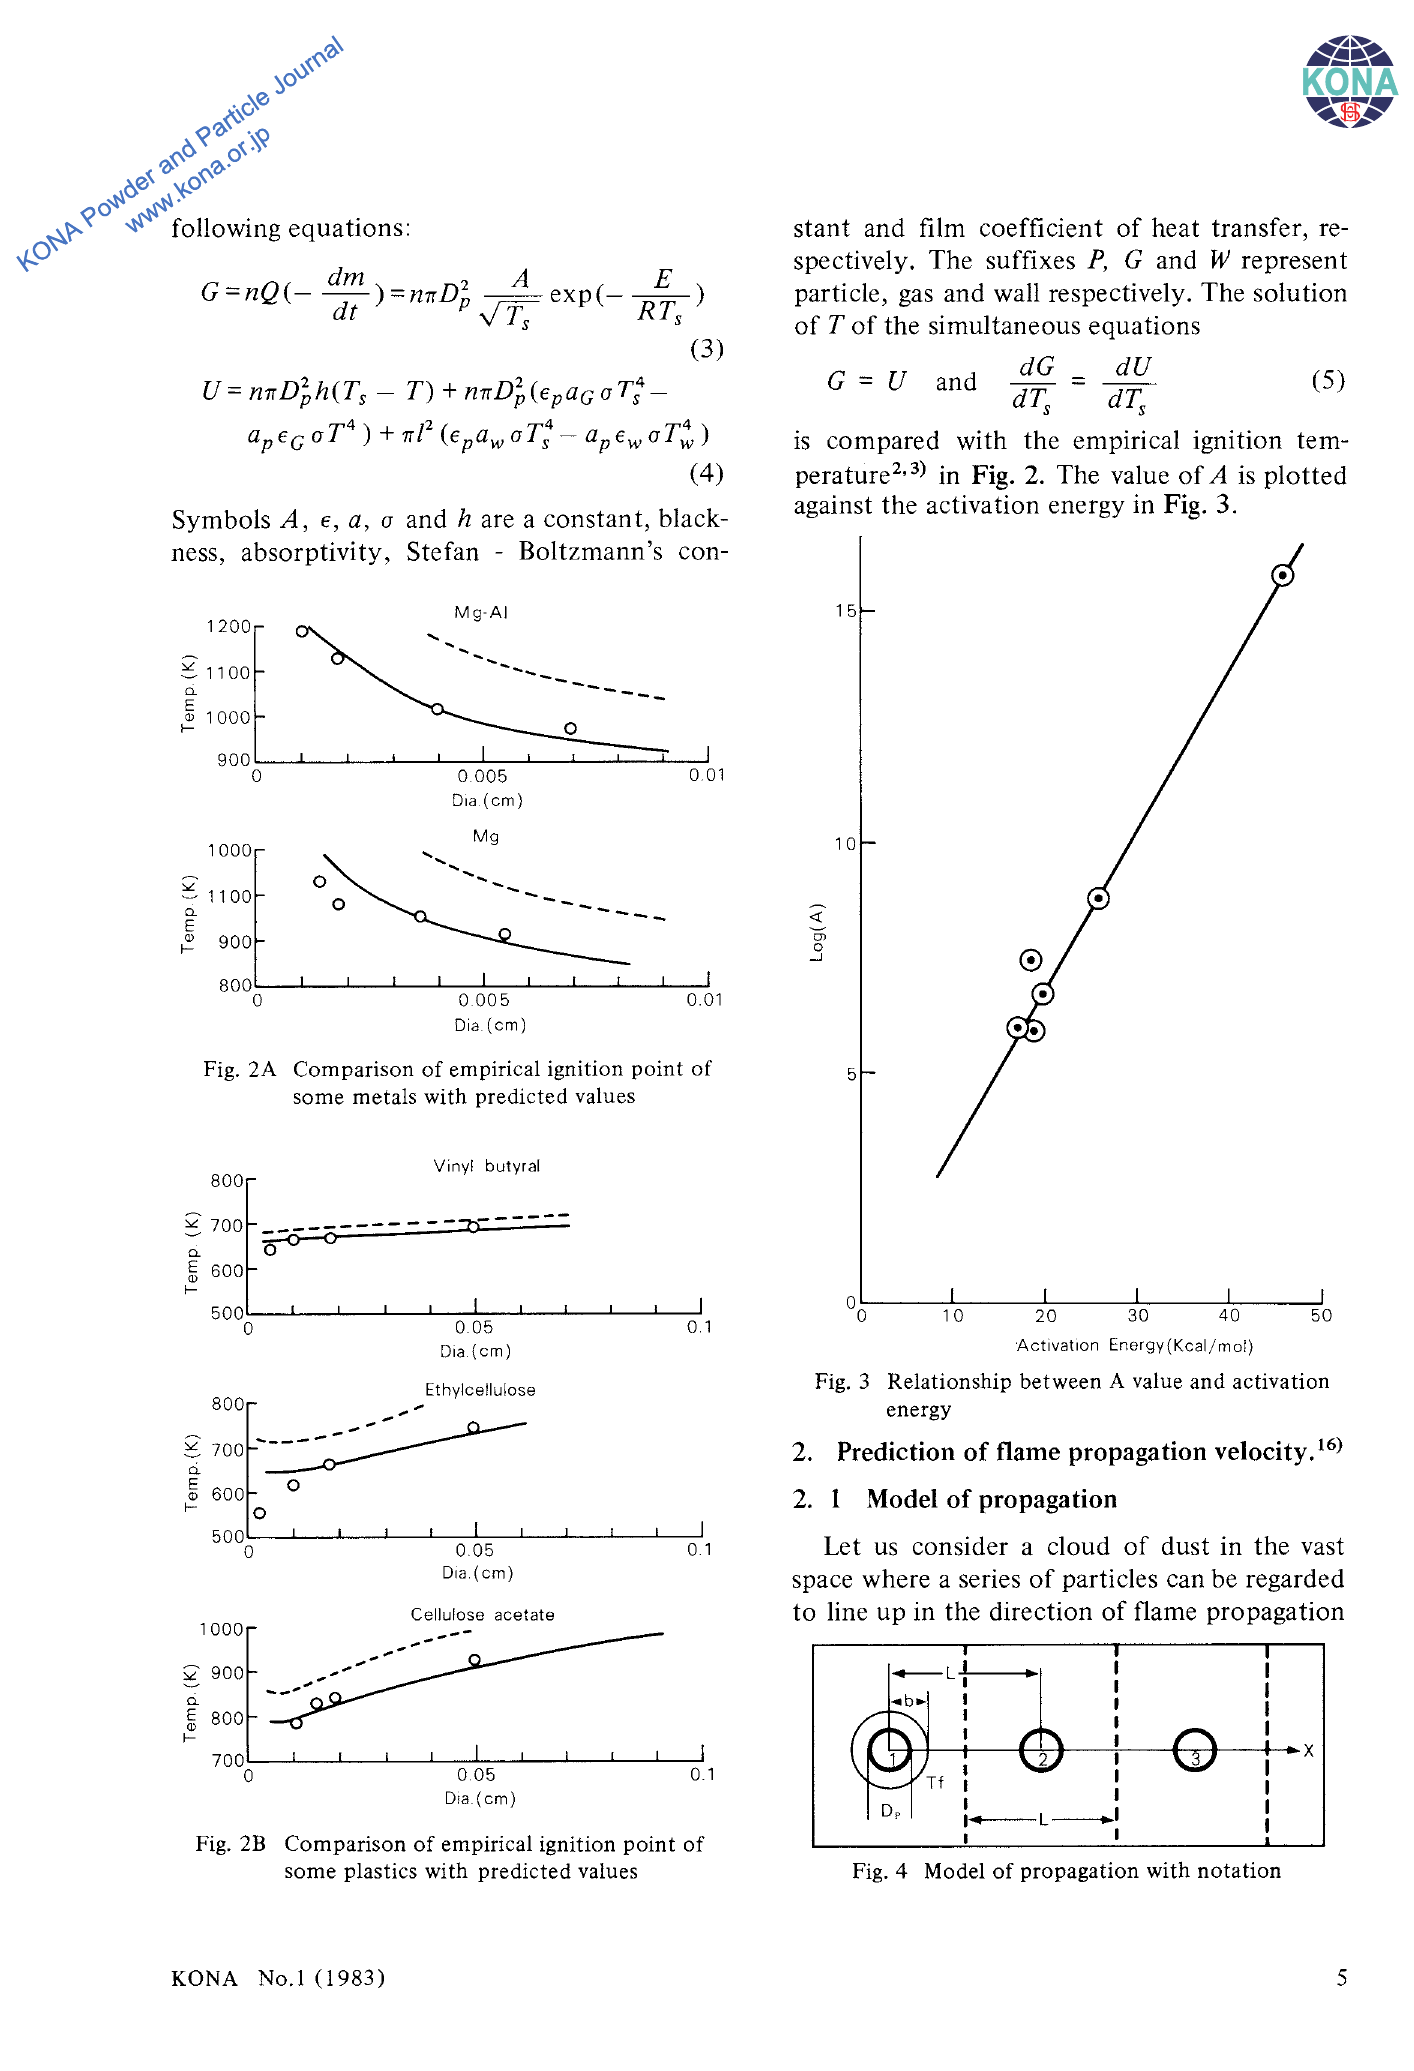
Fig. 4 Model of propagation with